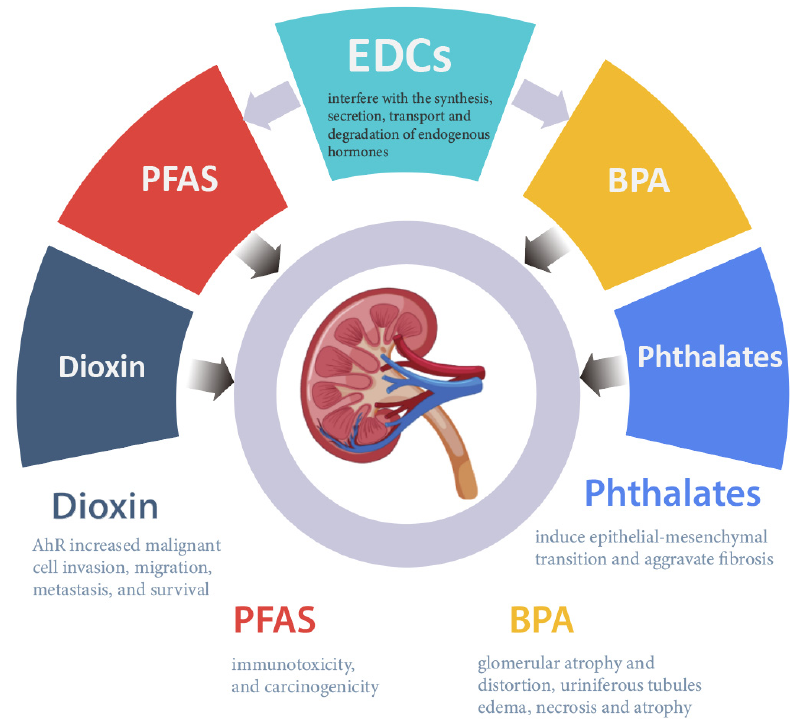
Figure 3. Diseases/conditions triggered due to exposure to